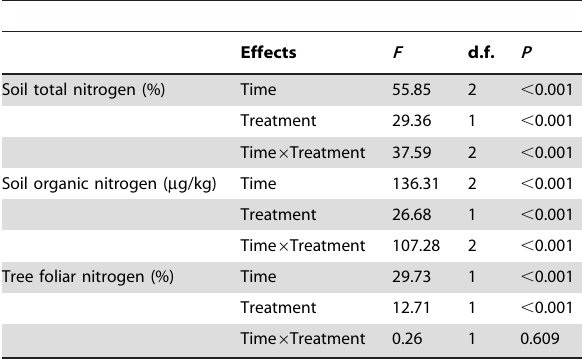
Table 1. Effects of carcass treatment, time, and their interaction on soil and tree leaf nitrogen